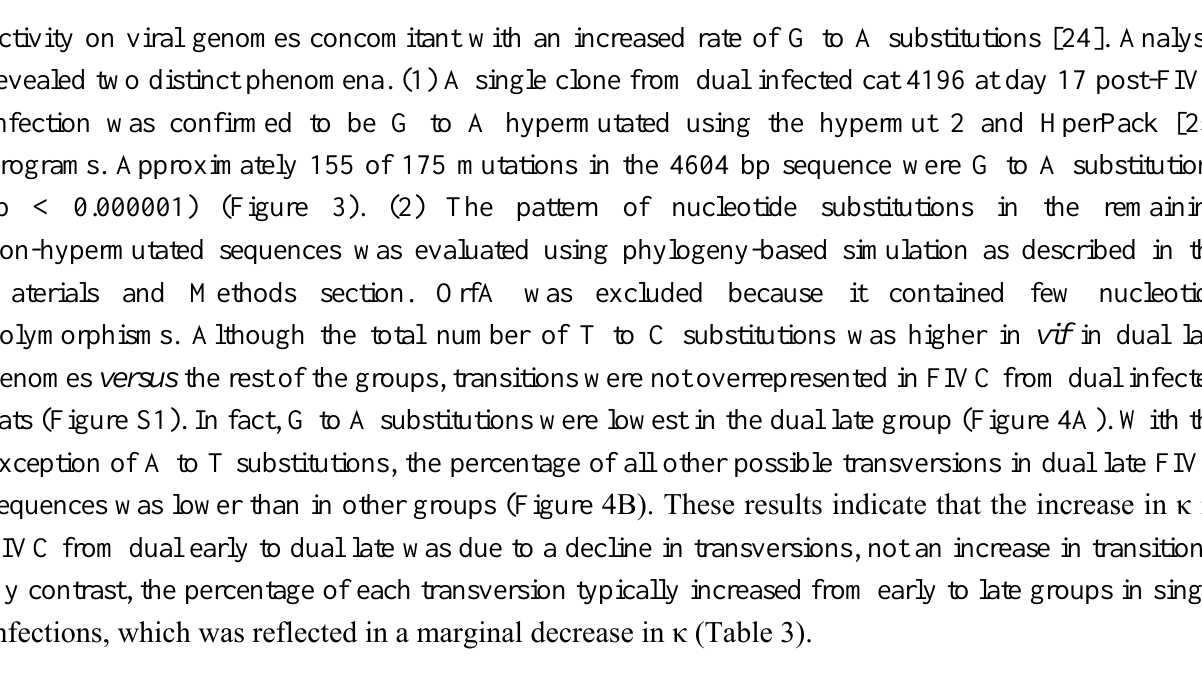
Figure 3. Nucleotide substitution frequency in a hypermutated clone from a dual infected cat. ( A ) Plot of percentage A versus G for all clones in all the four groups. The outlier clone, dF96B68_d45, is identified in the upper left quadrant. ( B ) Specific mutations noted in the hypermutated clone relative to parental virus. Inset indicates non-G to A transitions on an expanded